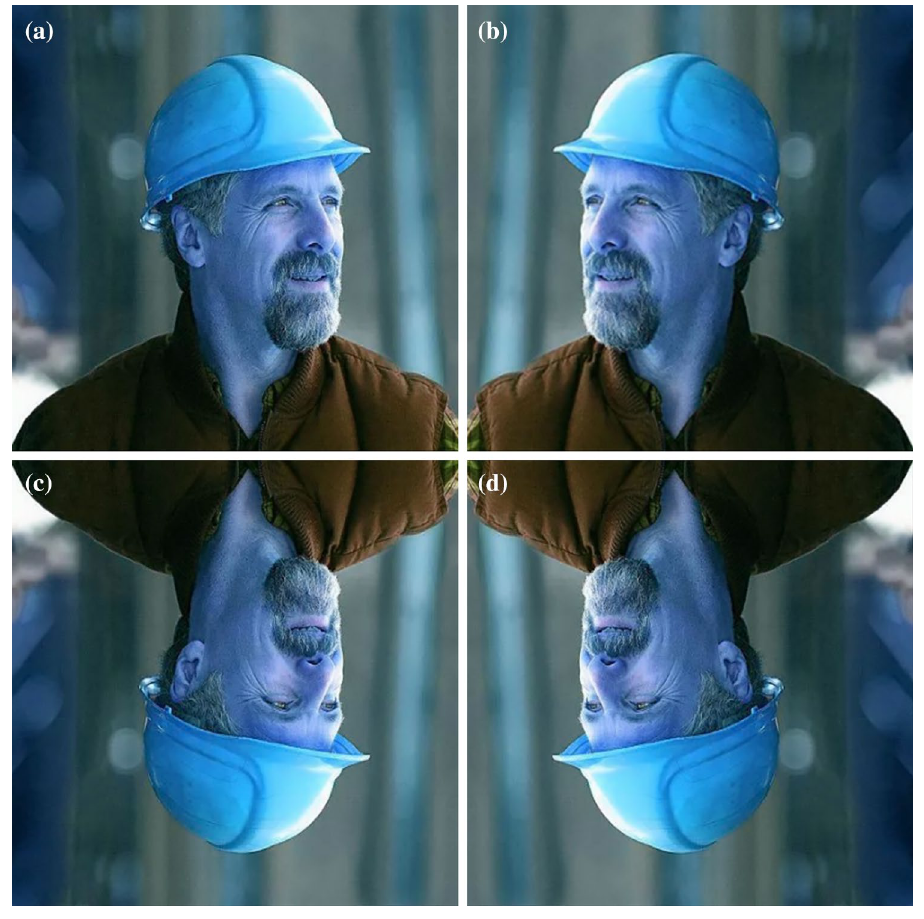
Figure 10. Preprocessing results of the image: ( a ) represents the initial image, ( b ) represents the image after horizontal rotation, ( c ) represents the image after vertical rotation, and ( d ) represents the image after horizontal and vertical